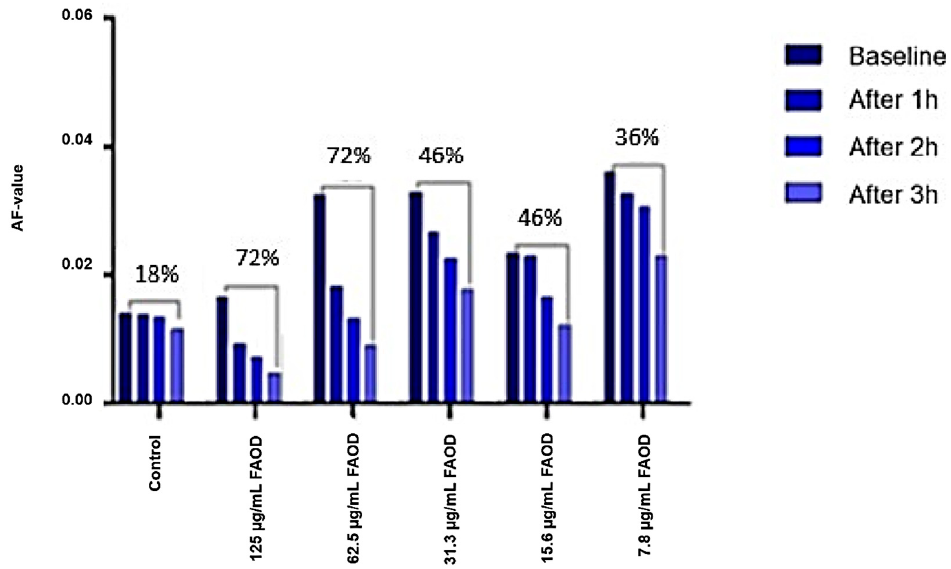
Figure 4. Auto- fl uorescence of human lenses following FAOD treatment.